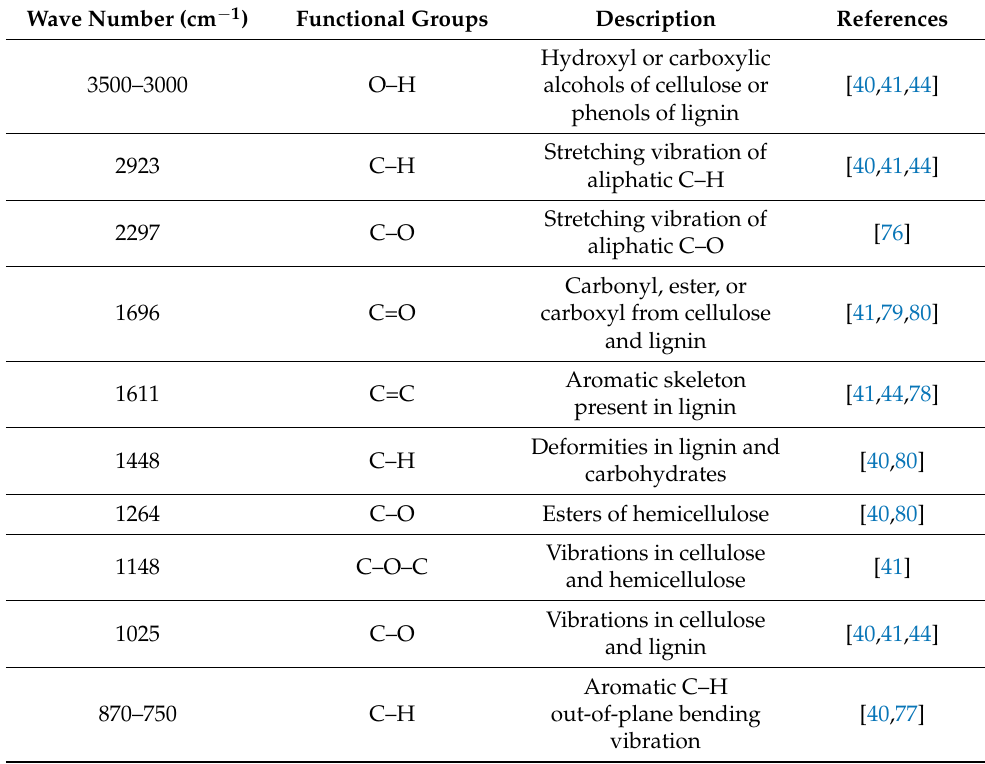
Table 5. Functional groups of SB, HC-200, HC-240, and